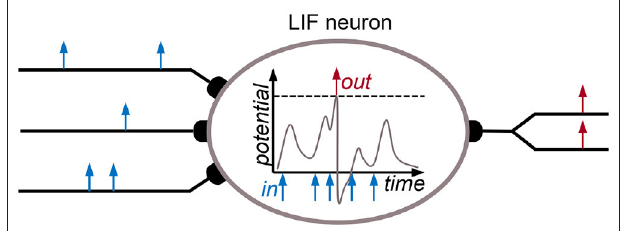
FIGURE 4 | Schematic illustration of a leaky integrate & fire (LIF) neuron, where multiple spikes (blue) from different input neurons lead to an output spike (red) of the given neuron. In the center, the course of the membrane potential over time is shown: When reaching the spike threshold (dashed line), the potential is reset and a spike is sent out to other